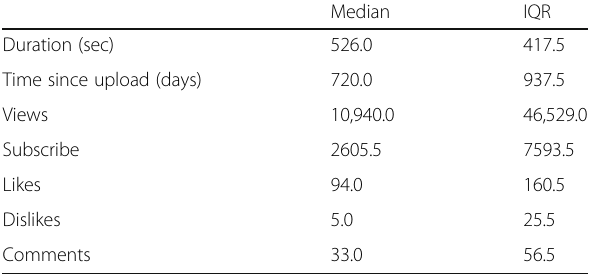
Table 3 Descriptive statistics (median, interquartile range; IQR) Table 4 P values from the median regression